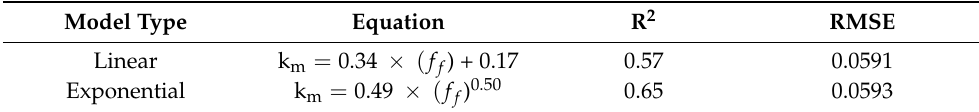
Table 4. Models for light extinction coefficient as a function of fractions of foliage cover ( f f ), and the goodness of fit (R 2 ) and root mean square errors (RMSE) of those